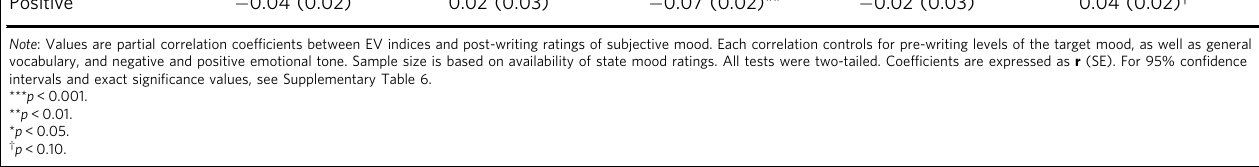
to feeling negatively after writing ( r = 0.21, SE = 0.02, 95% CI: